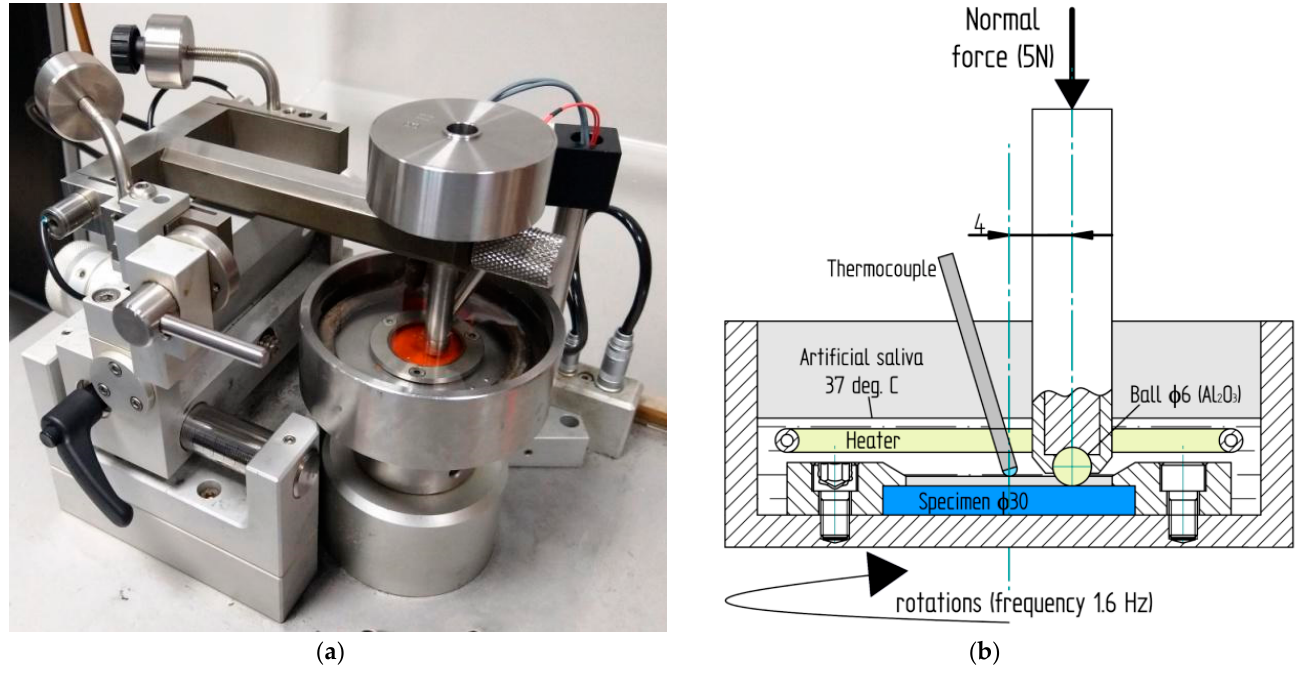
Figure 6. Ball-on-disc wear-testing machine ( a ) and schematic representation (cross section) of sliding wear test ( b ).